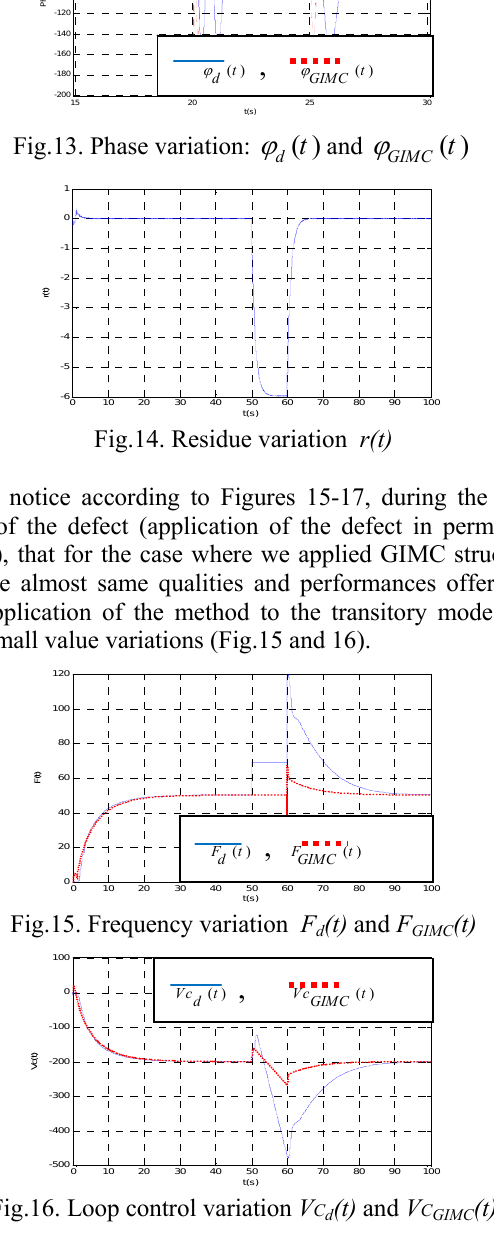
(t) and V C d GIMC